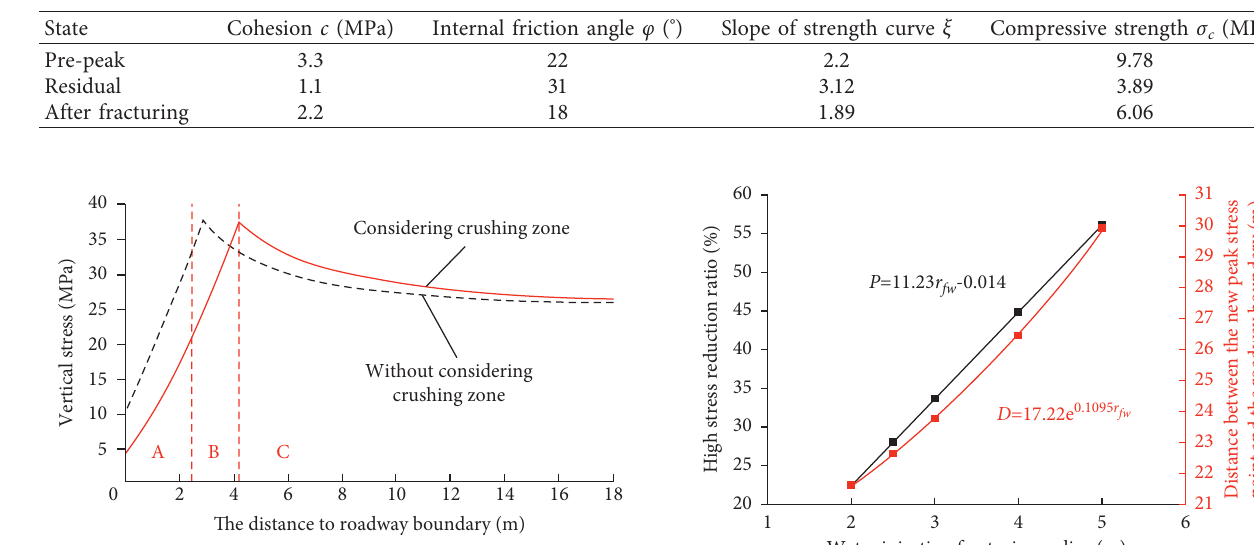
Figure 5: Vertical stress redistribution of roadway sidewall: A, B, and C represent crushing zone, plastic zone, and elastic zone, respectively.